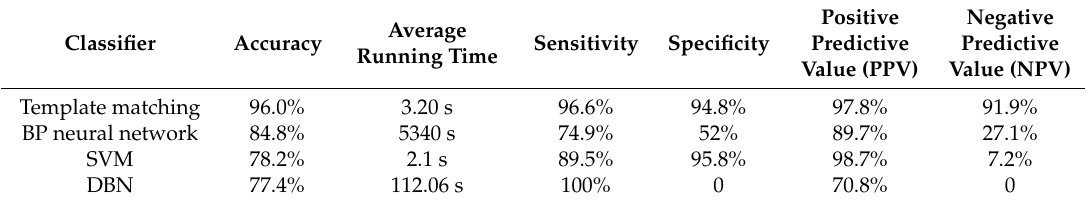
Table 10. Comparison of four